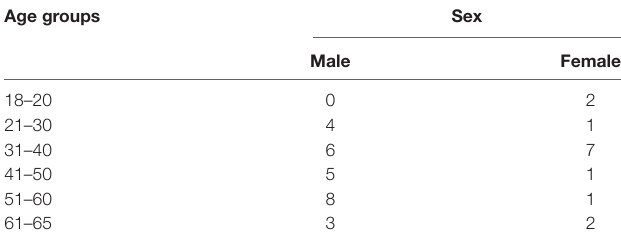
TABLE 1 | Age and sex distribution of participants in phase 1 of the clinical trial. Age